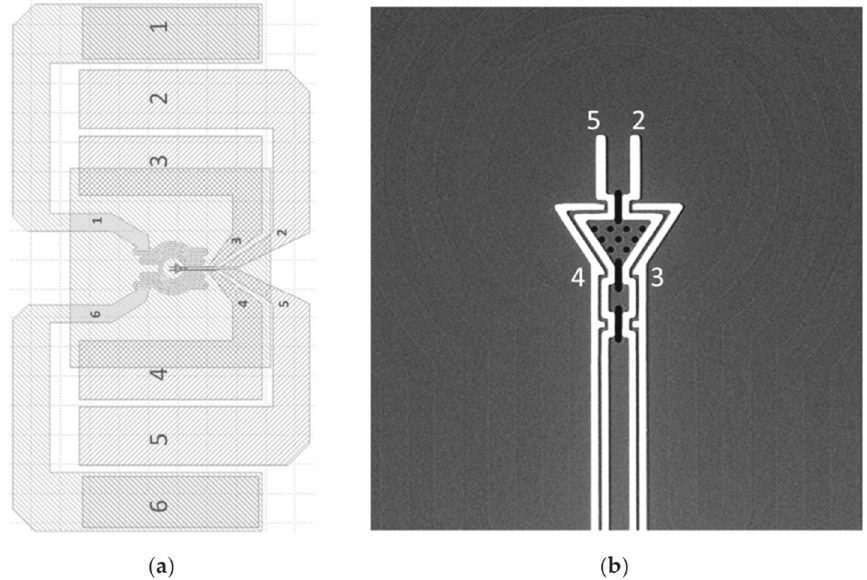
Figure A1. DENSsolutions MEMS chip. ( a ) Overview of the two heating (1,6) and four biasing (2,3,4,5) electrodes. ( b ) Enlarged section of central area of the SiN membrane with the four biasing electrodes on top. Between electrode 2 and 5, the windows (point and line geometry) are visible above which the TEM lamellae will be positioned. Published with permission of the authors [55]. Table A1. Step by step protocol for the in-situ lift-out and transfer procedure of a cross-sectional thin film lamella.